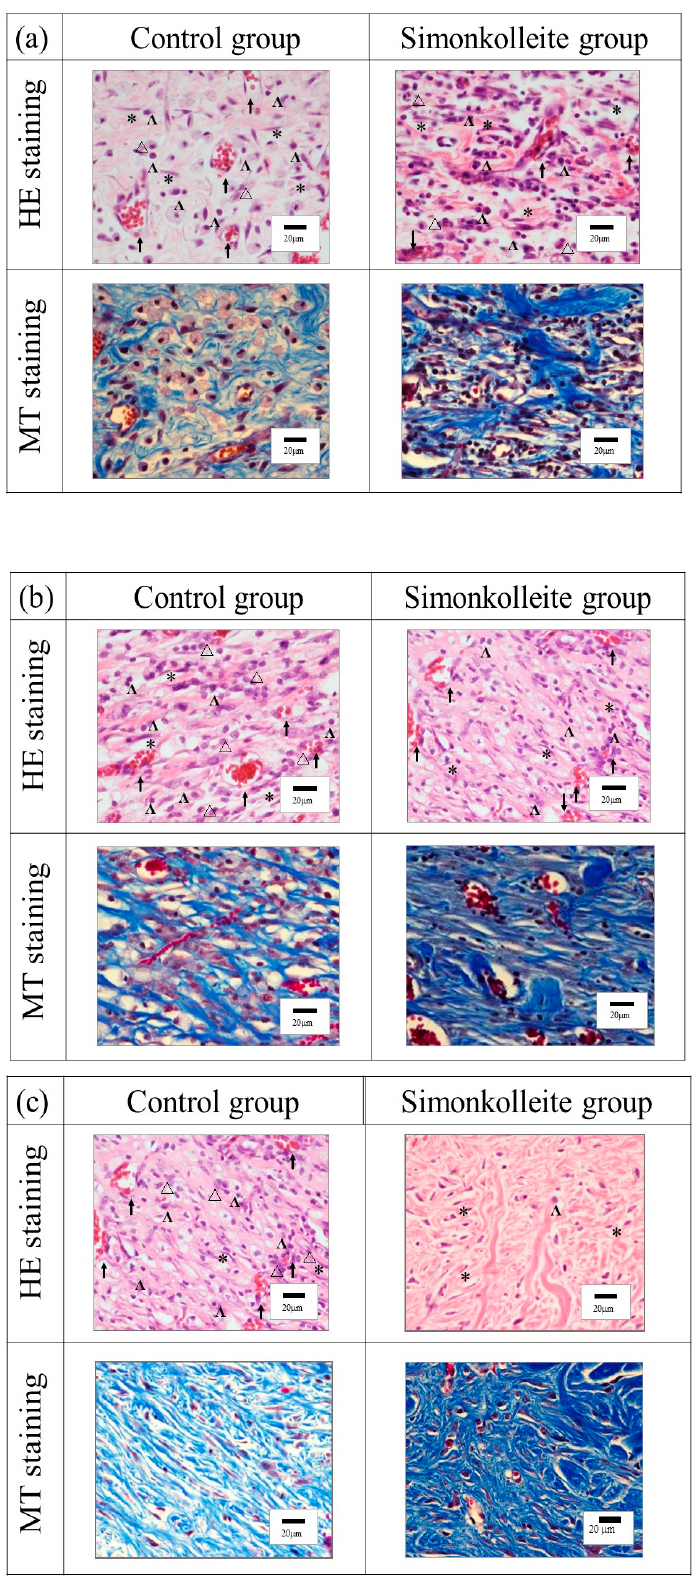
Figure 8. The high magnification images of HE- and MT-stained skin in the wound healing site after ( a ) 1 week, ( b ) 2 weeks, and ( c ) 4 weeks of healing time. ↑ : Angiogenesis; *: Fibroblast; ∆ : Granulocyte; Λ : Lymphocyte.